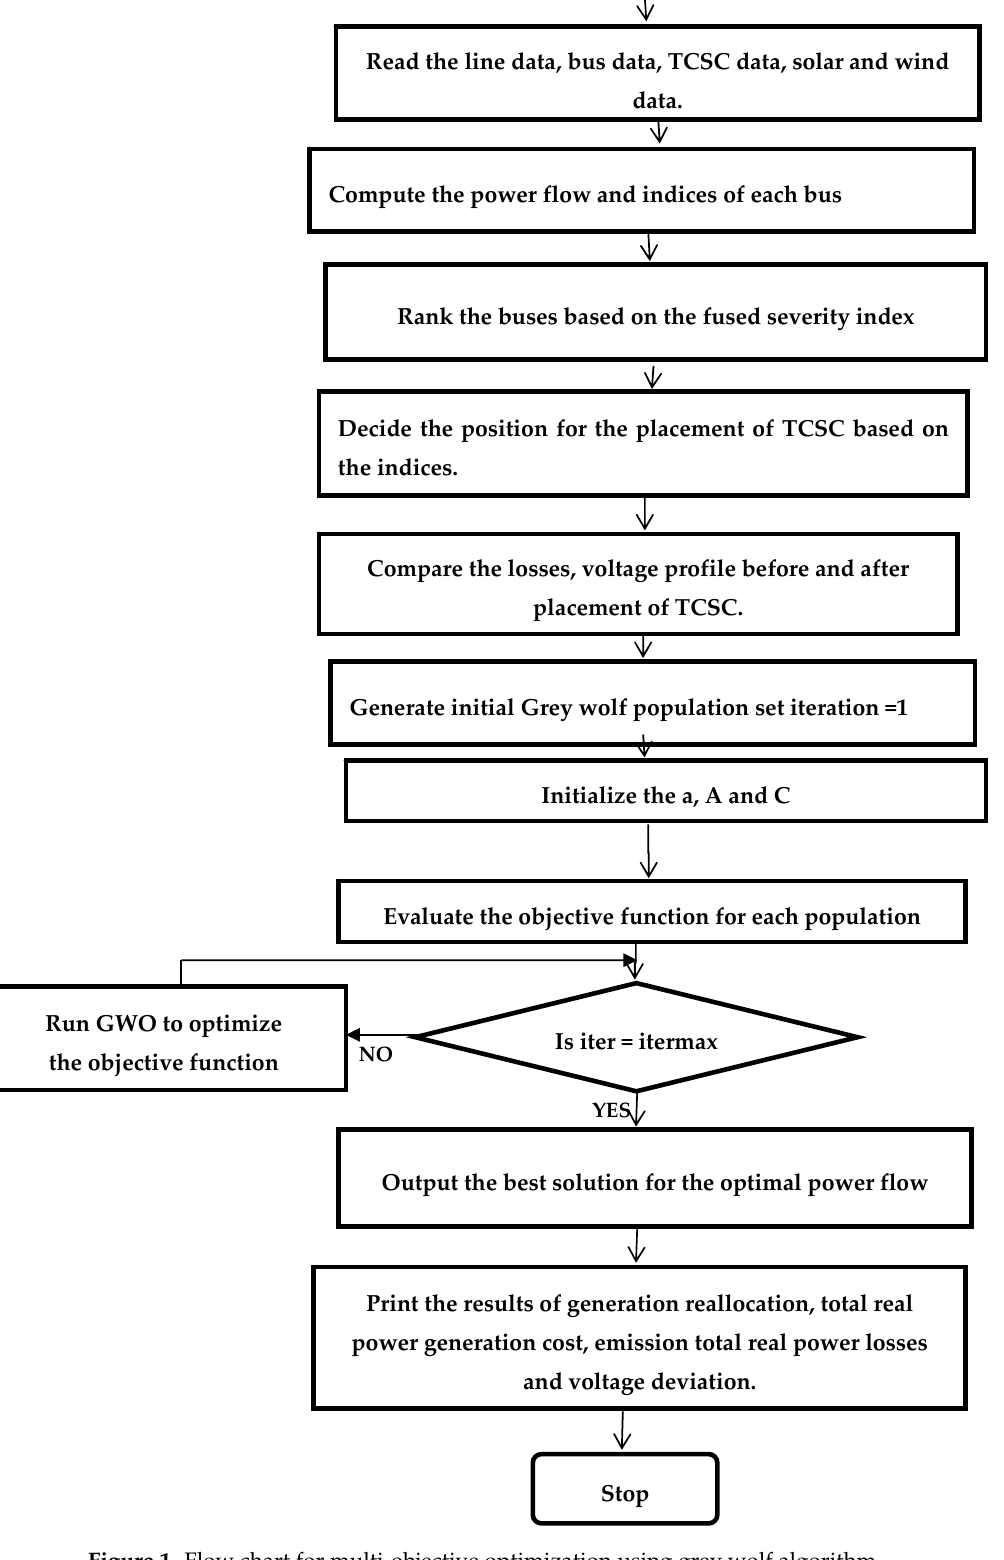
Figure 1. Flow chart for multi-objective optimization using grey wolf algorithm